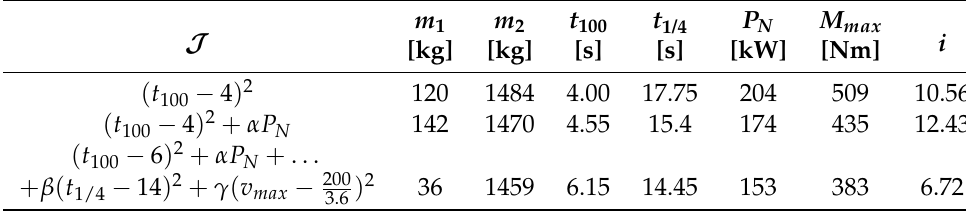
Figure 13. Optimized powertrain. Table 1. Powertrain optimization for different performance